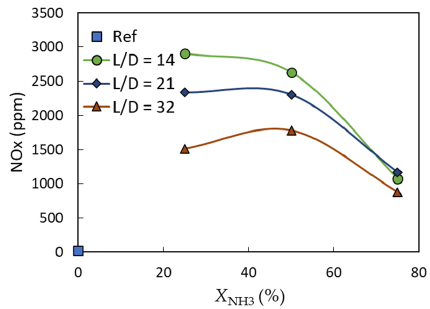
Figure 8. Measured NOx emission for ϕ = 0.9 as function of ammonia fractions at different mixing length ratios.